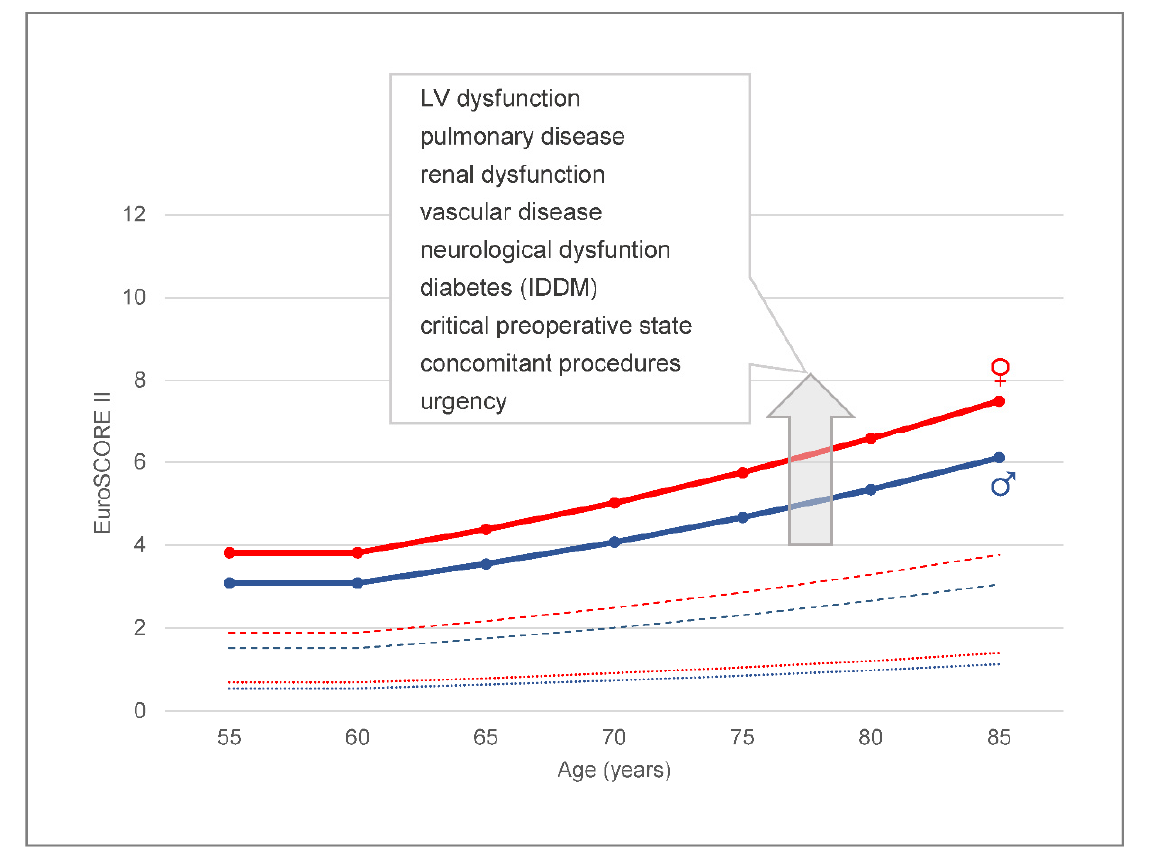
Figure 2. Operative risk in healthcare-associated infective endocarditis. The graphs show the calculated risk of mortality (EuroSCORE II) of isolated redo valve replacement due to prosthetic valve endocarditis (PVE) in female (red line) and male (blue line) patients (no further comorbidities) in comparison to isolated redo valve replacement not due to IE (interrupted lines) and isolated primary coronary artery bypass grafting (dotted lines) [http://www.euroscore.org/calc.html, accessed on 22 July 2022]. The insert lists patient- and cardiac-related factors leading to significantly increased risk. For example, in a 73-year-old female patient requiring urgent surgery due to PVE and presenting with end-stage renal failure and moderate LV dysfunction, the calculated risk of mortality is 17%. IDDM, insulin-dependent diabetes